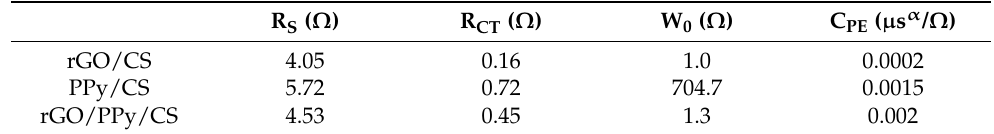
Figure 3. Water contact angle of pure carbon cloth ( a ) without APPJ treatment and ( b ) with APPJ treatment; rGO/CS-coated carbon cloth ( c-1 ) without DBDjet treatment and ( c-2 ) with DBDjet treatment; PPy/CS-coated carbon cloth ( d-1 ) without DBDjet treatment and ( d-2 ) with DBDjet treatment; and rGO/PPy/CS-coated carbon cloth ( e-1 ) without DBDjet treatment and ( e-2 ) with DBDjet treatment. Table 1. Capacitive contribution of SCs with rGO/CS, PPy/CS, and rGO/PPy/CS